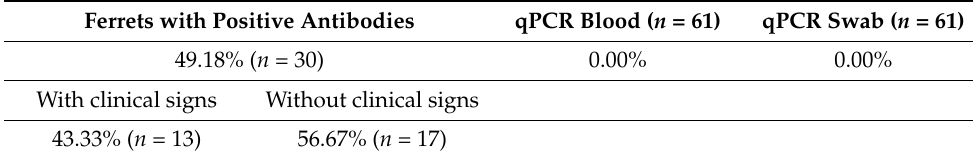
Table 2. Results of PCR and antibody tests for Aleutian disease in ferrets ( n = 61) from two provinces in